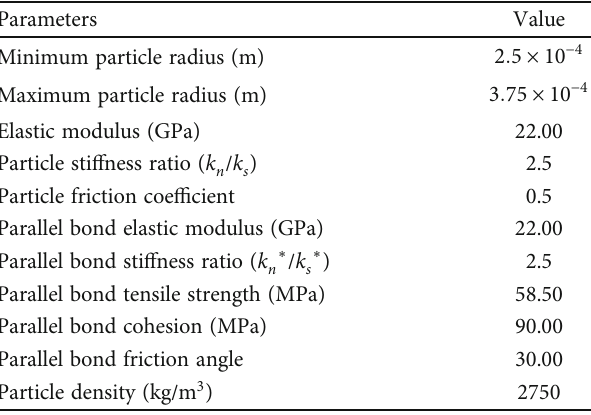
Figure 2: Geometric model of drilling core. Table 1: Micromechanical parameters of PFC 2D calculation